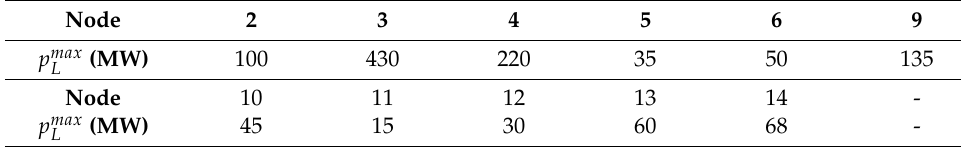
Table 4. Load node parameters.